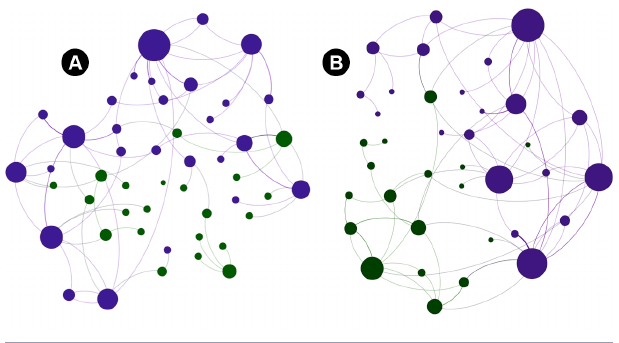
Fig. 3. Medicinal plant exchange networks (undirected) by village. (A) Less isolated village. (B) More isolated village. Purple nodes, women; green nodes, men; node size indicates degree centrality.